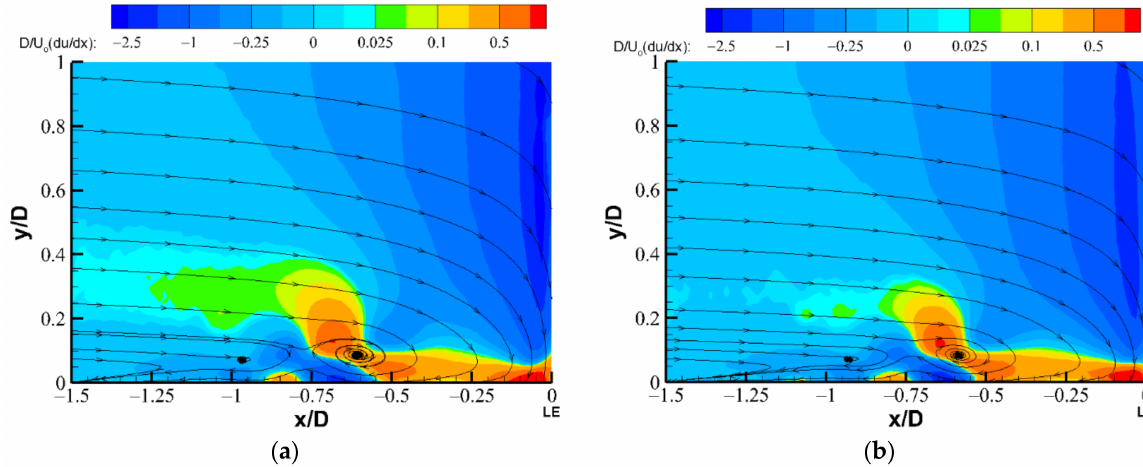
Figure 19. Ensemble-averaged x -normal strain rate d u /d x at the z = 0 cm plane when ( a ) H / D = 0, and ( b ) H / D = 1.5.